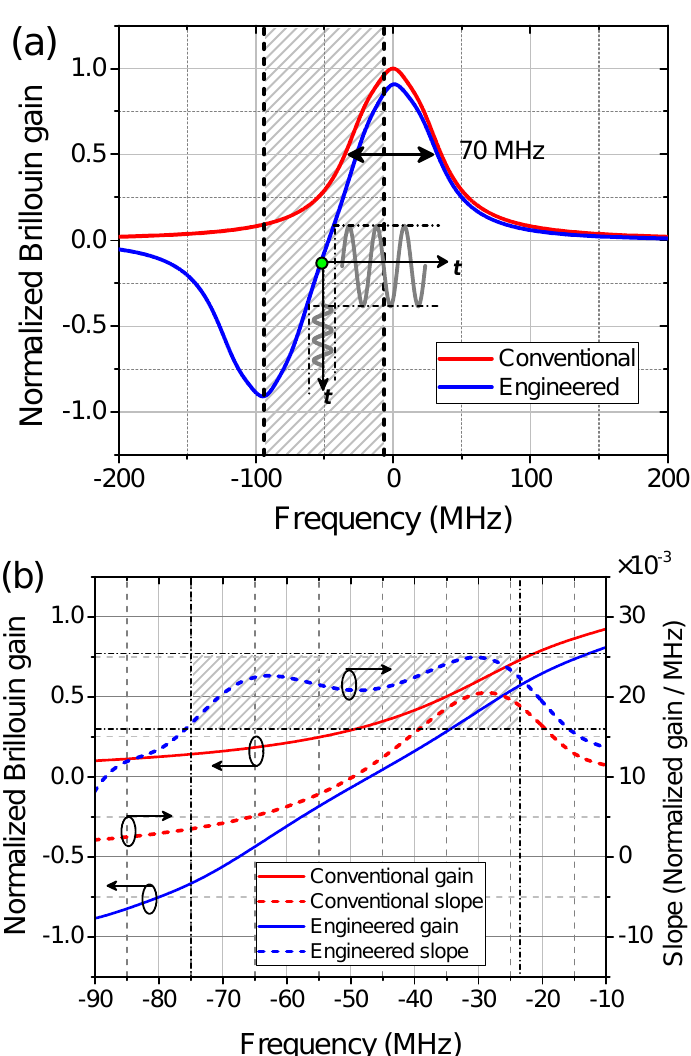
blue dashed curve in the shadowed area in Figure 7b indicates that a well engineered BGS is able to provide an extended linear range with even a steeper slope.